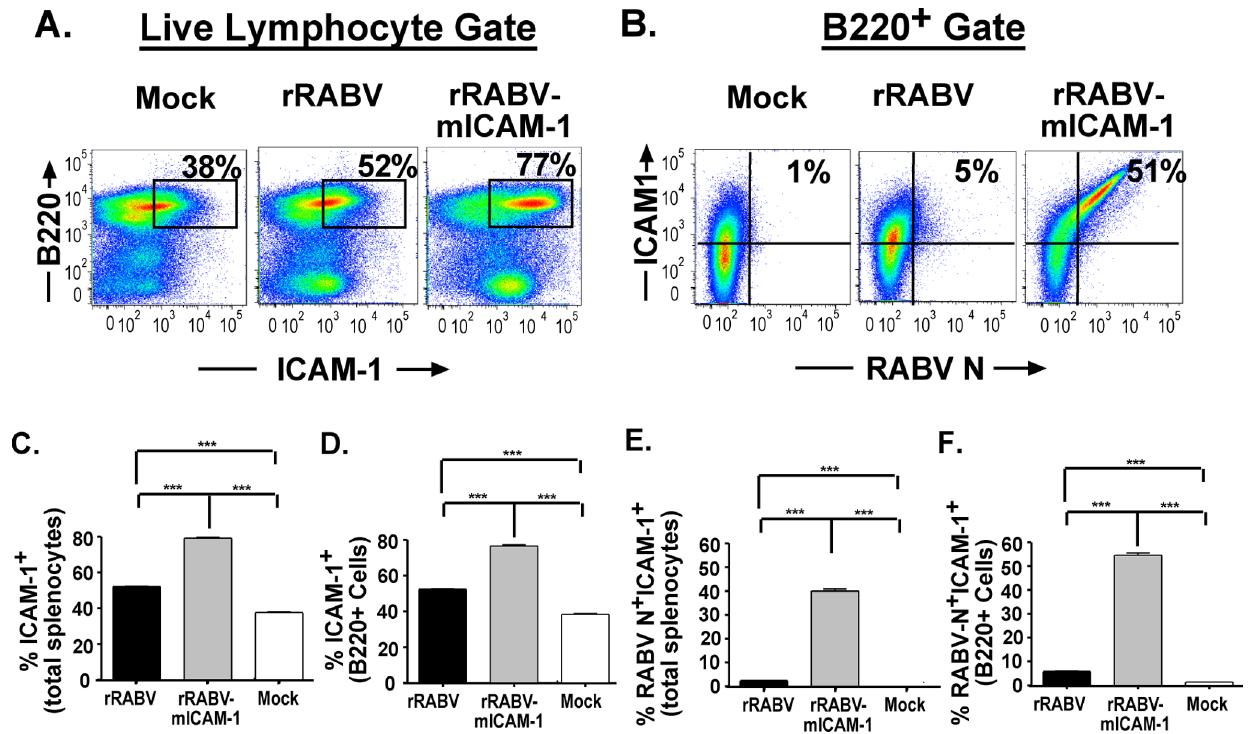
Figure 3. rRABV infection results in the upregulation of ICAM-1 expression, which is augmented by infection with rRABV-mICAM-1. Total naı¨ve primary murine splenocytes were infected as described in Figure 2 and then stained for B220, ICAM-1, and RABV-N for analysis by flow cytometry. A) Representative gating strategy of total live lymphocytes gated on ICAM-1 and RABV N staining. B) Representative gating strategy of B220 + B cells gated on RABV N and ICAM-1. C) Percent ICAM-1 + cells in the total live lymphocyte population. D) Percent ICAM-1 + cells in the B220 + cell population. E) Percent RABV N + ICAM-1 + cells in the total live lymphocyte population. D) Percent RABV N + ICAM-1 + cells in the B220 + cell population. To compare two groups of data, we used an unpaired, two-tailed Student’s t test. (* p , 0.05; **, p , 0.01; ***, p ,